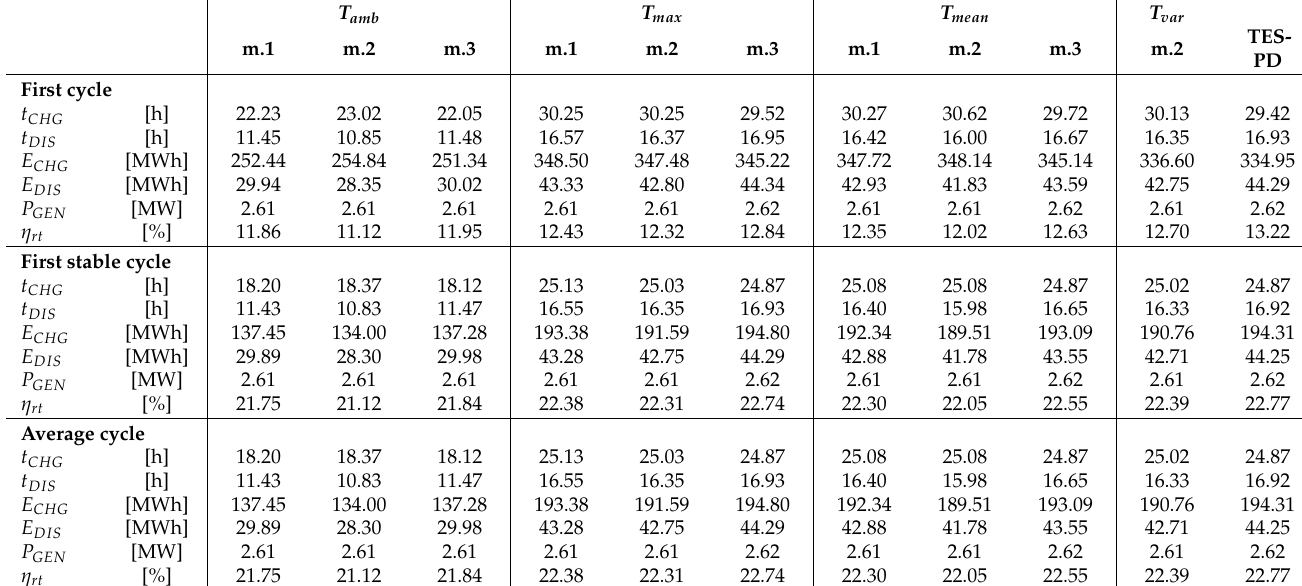
Table 1. Comparison among models when the fluid and solid properties ( c p , s , c p , f , k f and µ f ) are computed at a fixed reference temperature ( T amb , T max and T mean ) and at a temperature, T var , reliant on the layer and time (only for m.2 and TES-PD). In order to compare the models, the heat loss coefficient U i and the solid effective thermal conductivity, k s , ef f , were both set equal to 0, while the charging tolerance was set equal to 10 K. The plant performance parameters are listed for the first cycle, the first stable cycle and average